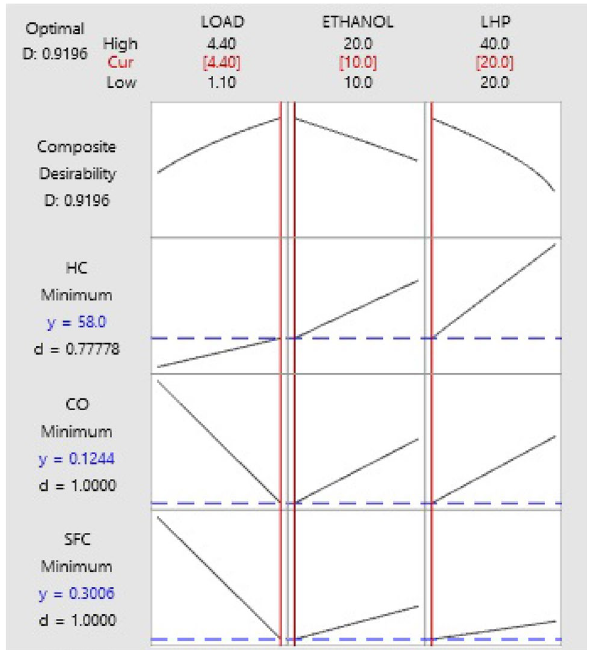
Figure 14. Optimization plot for SFC, CO, and HC.